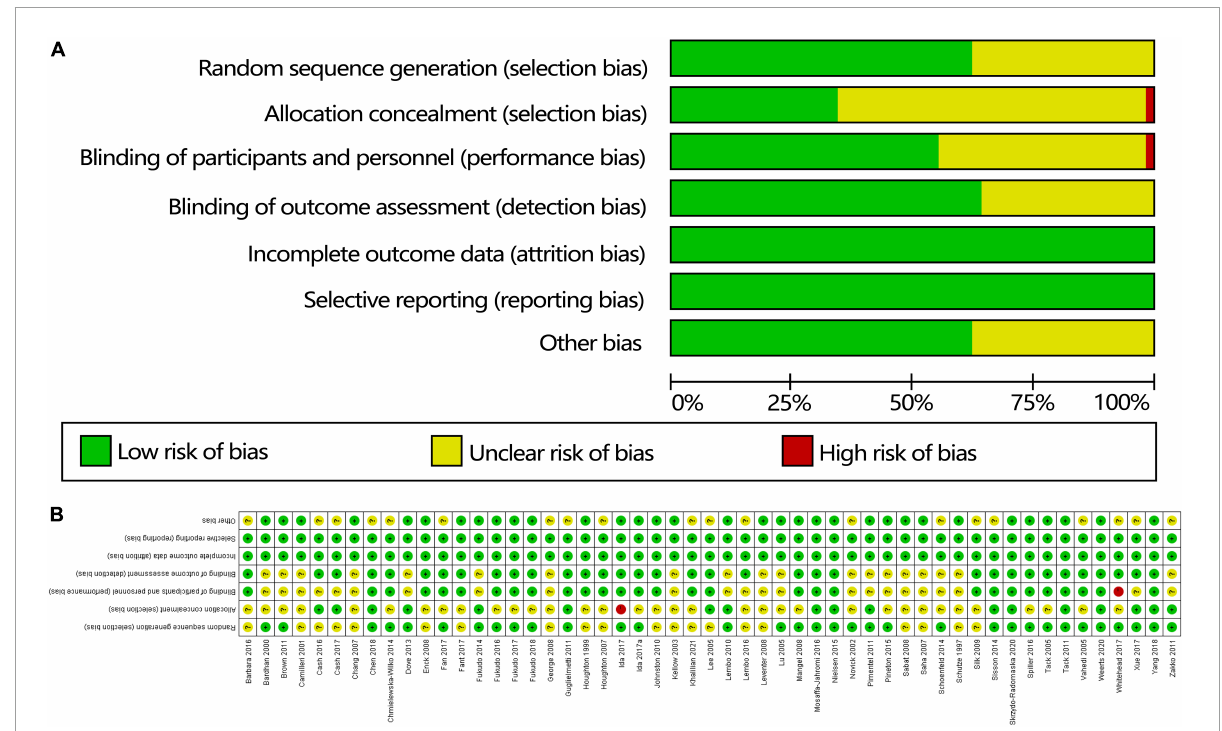
FIGURE2 Quality of the studies based on the Cochrane risk-of-bias assessment tool: (A) risk-of-bias summary and (B) risk-of-bias table.